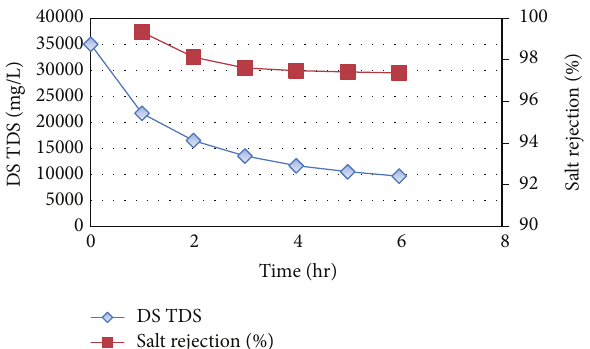
Figure 7: DS salinity and salt rejection% as a function of time (1st stage of FO-batch process).